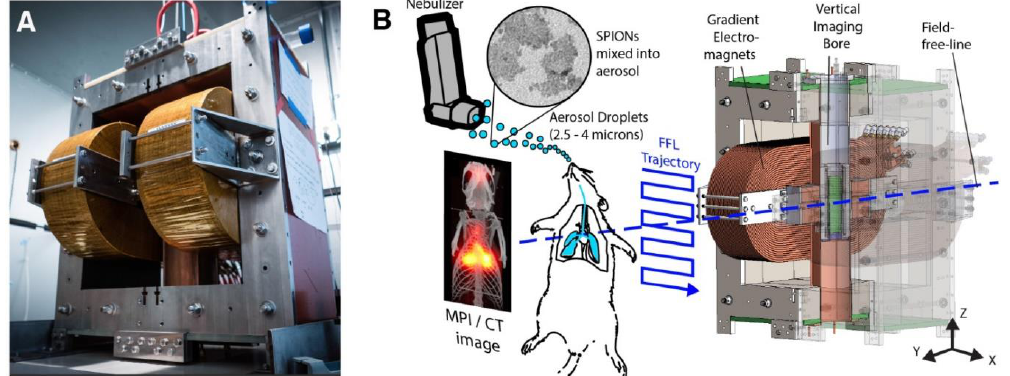
Figure 4 . Hardware setup used in magnetic particle imaging (MPI) scans using SPIONs. ( A ) The Berkeley field-free-line MPI preclinical scanner. ( B ) To form a projection image, the magnetic field (FFL) rasters across a trajectory as shown, imaging the in vivo distribution of SPIONs in a rat. Multiple such projections can reconstruct a 3D MPI image similar to CT. Reproduced with permission from Ref. [48] .